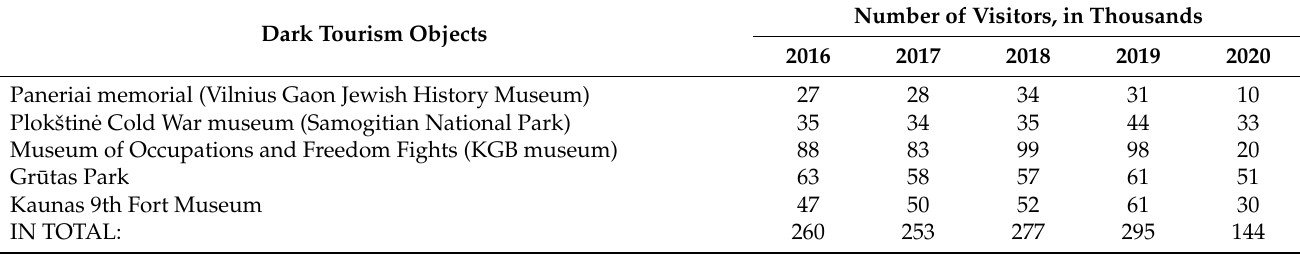
Table 2. Dark tourism objects in Lithuania (2016 – 2020) 3 .